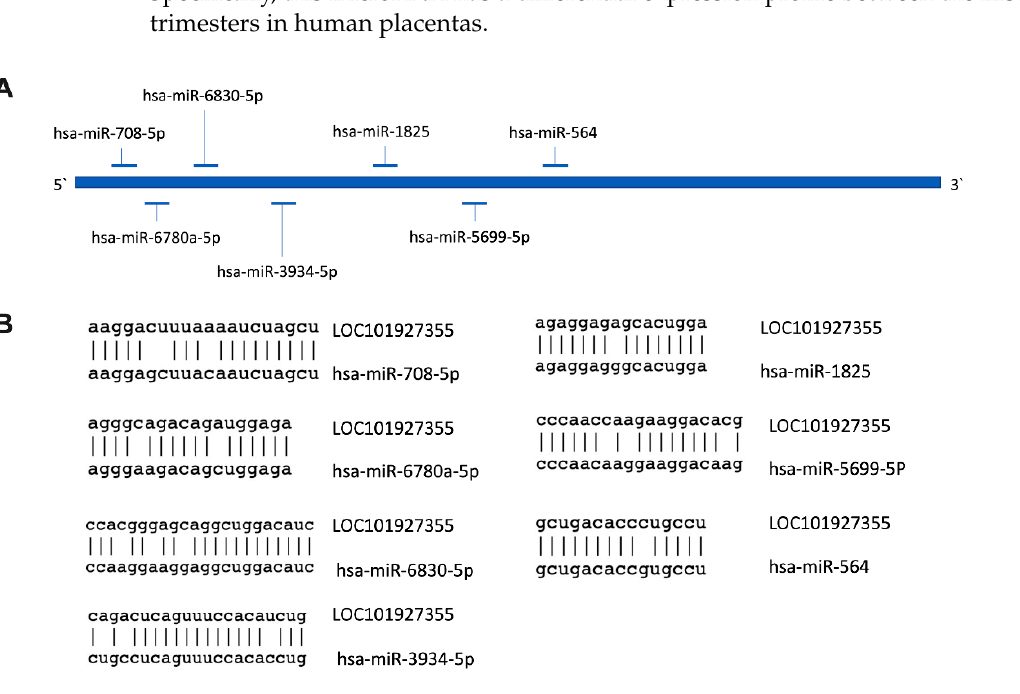
Figure 5. Putative binding sites for miRNAs to the lncRNA LOC101927355. ( A ) Schematic representa- tion of LOC101927355 and the predicted miRs’ target sites; ( B ) alignment of LOC101927355 to ma- ture miRNAs’ targets.